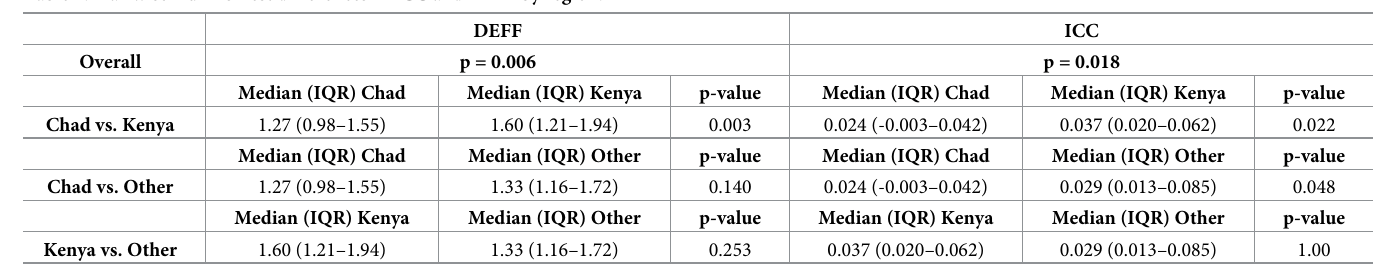
Comparisons with p < 0.05 considered statistically